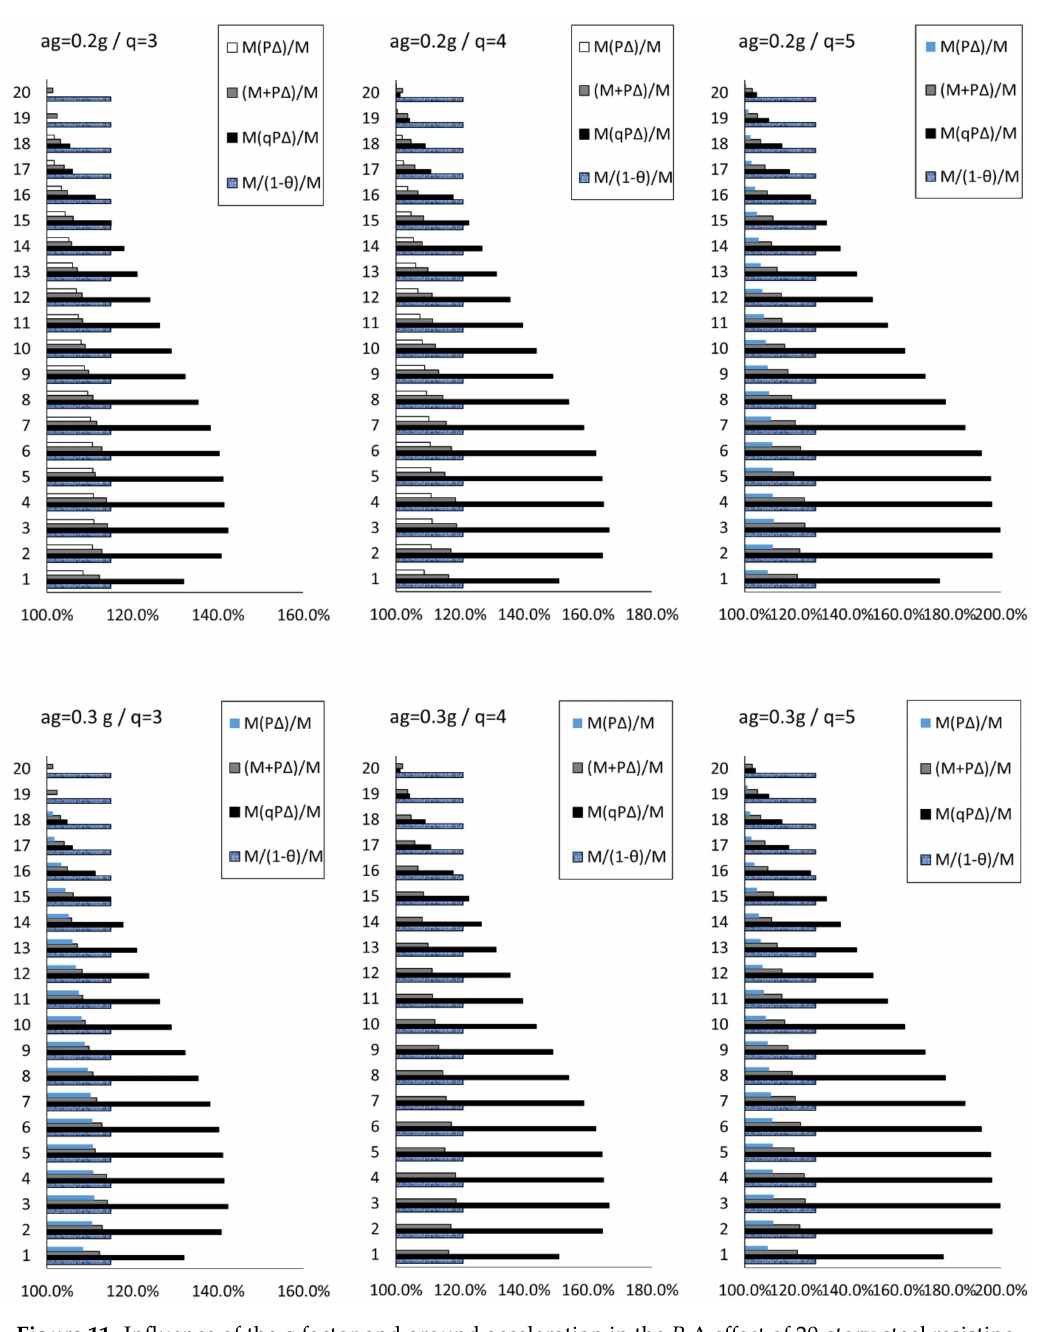
Figure 11. Influence of the q factor and ground acceleration in the P - ∆ e ff ect of 20-story steel resisting frame structure. Illustration of di ff erent approaches for the estimation of the maximum acting moment in the story